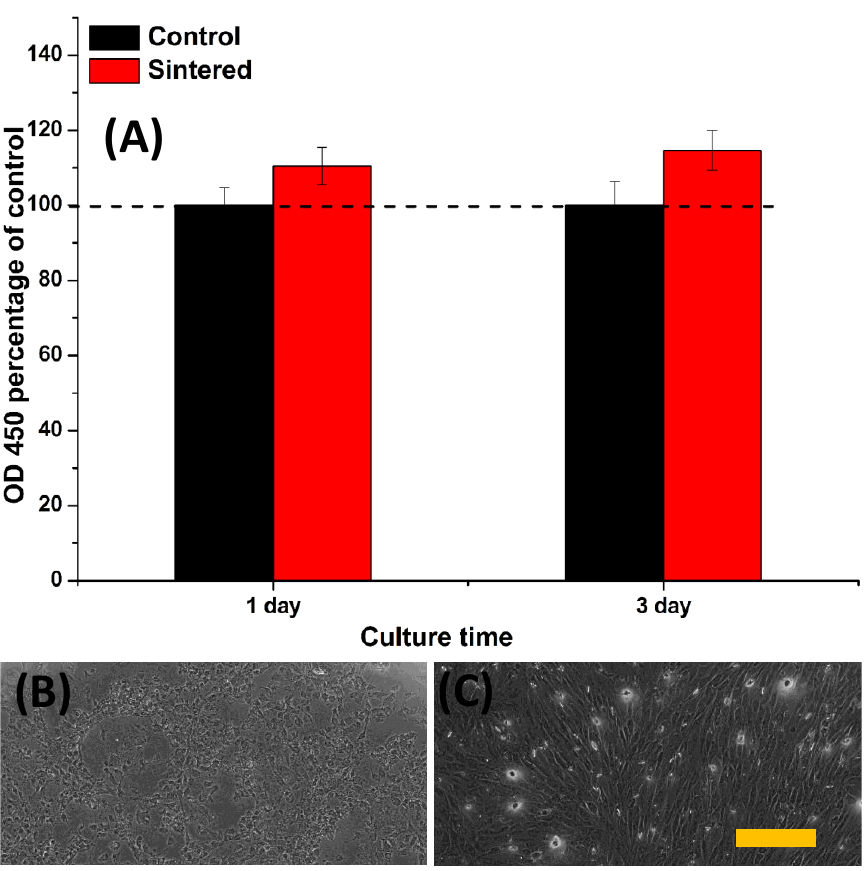
Figure 6. ( A ) MTT proliferation assay and ( B , C ) SEM images of MC3T3 osteoblast-like cells. The scale bar represents 100 µm.